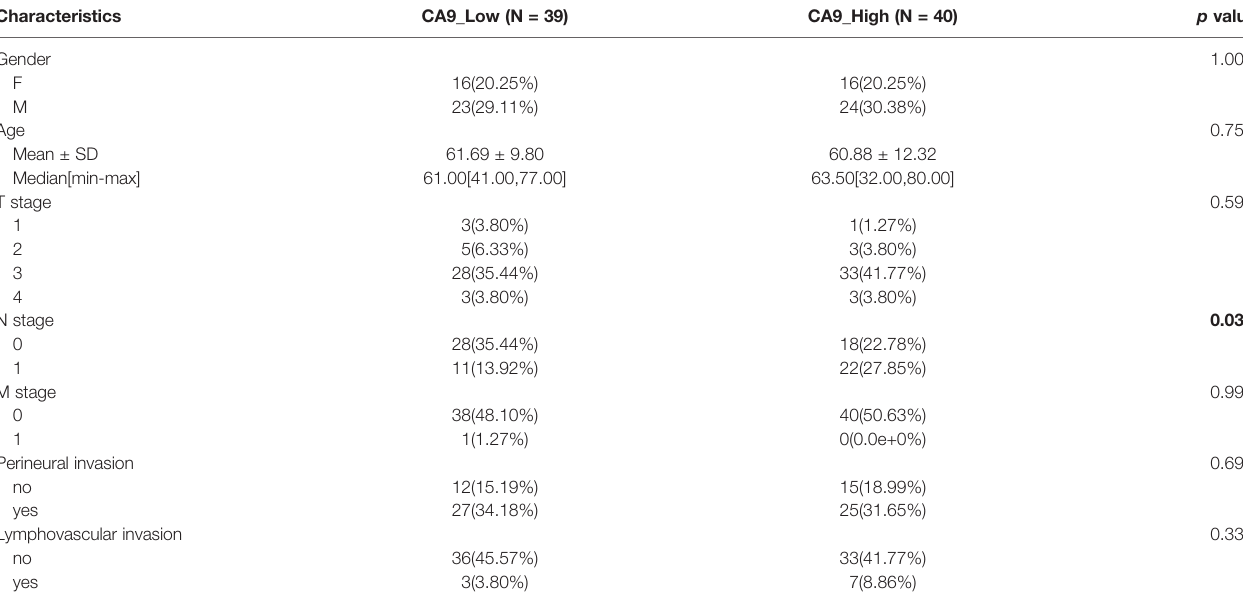
TABLE 1 | Clinical characteristics of patients included in TMA analysis.